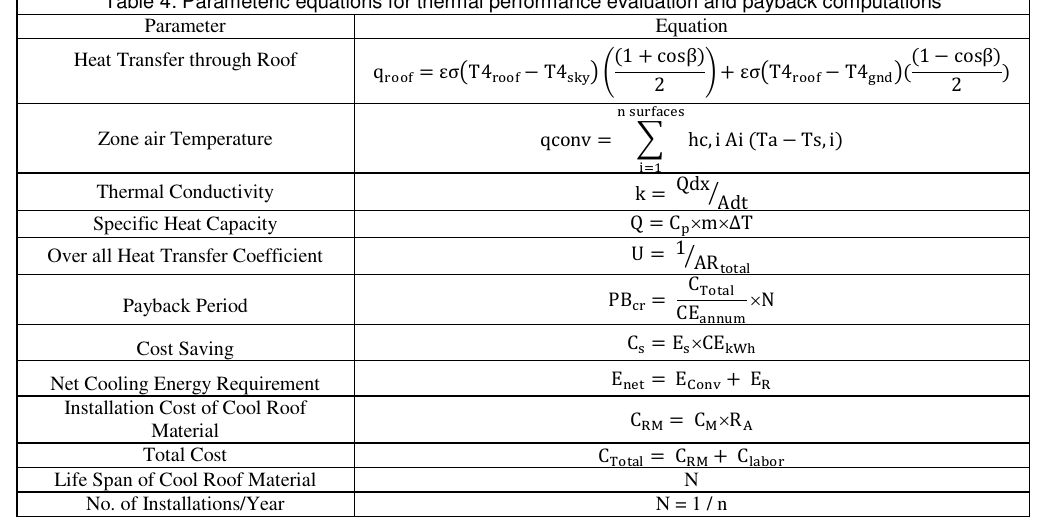
Table 4: Parameteric equations for thermal performance evaluation and payback computations